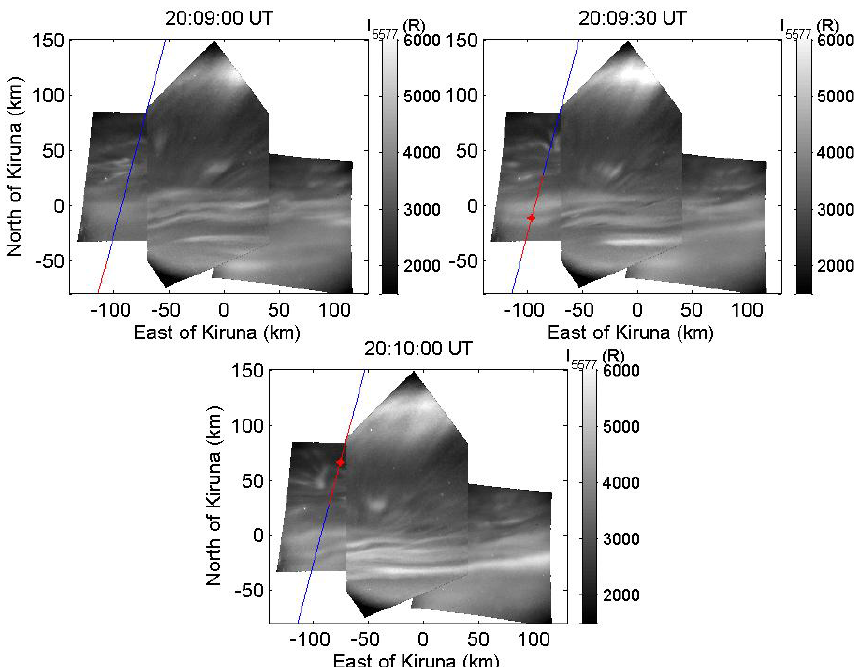
Fig. 4. Abisko, Nikkaluokta, and Silkkimuotka ALIS images of the aurora projected to 107km. The blue lines show the FAST footprint. Red asterisks indicate the position of FAST at the moment when the image was taken. Red lines indicate the time interval ± 15s around this